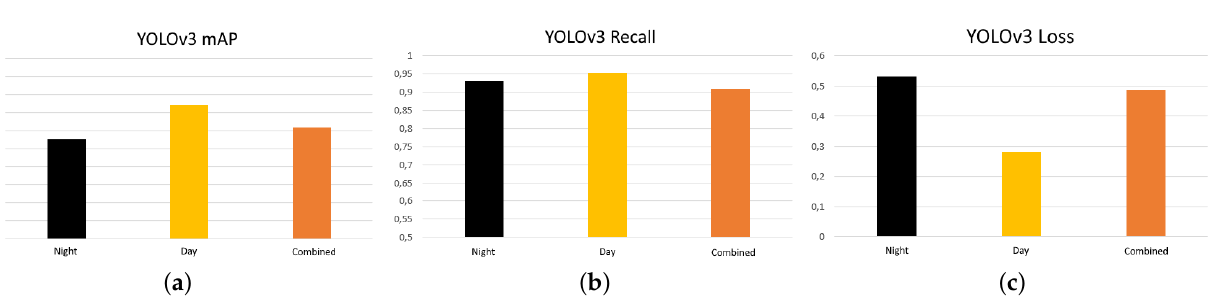
Figure 11. mAP, recall, and loss comparison for the YOLOv3 datasets. ( a ) mAP, ( b ) recall, and ( c ) loss. Source: Authors.